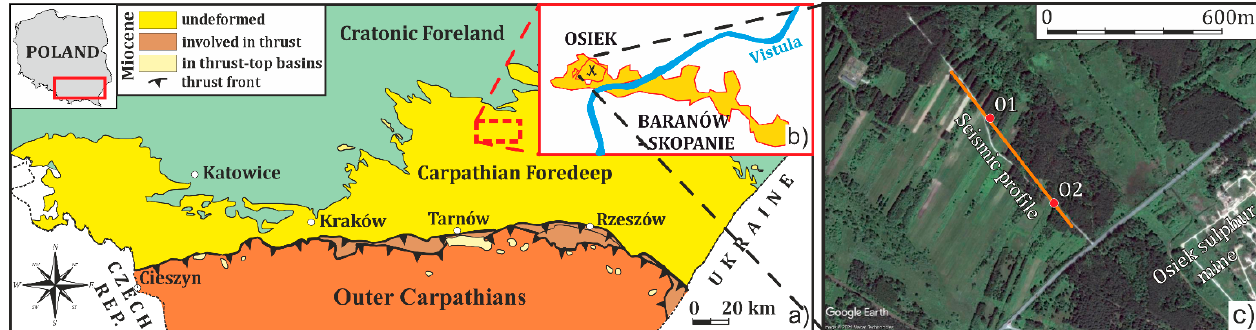
Figure 1. ( a ) Location of the study area ( dashed rectangle ) in the Polish Carpathian Foredeep; ( b ) Osiek sulphur deposit; ( c ) Location of seismic profile ( orange line ) and wellbores ( red circles ; source of map: Google Earth).